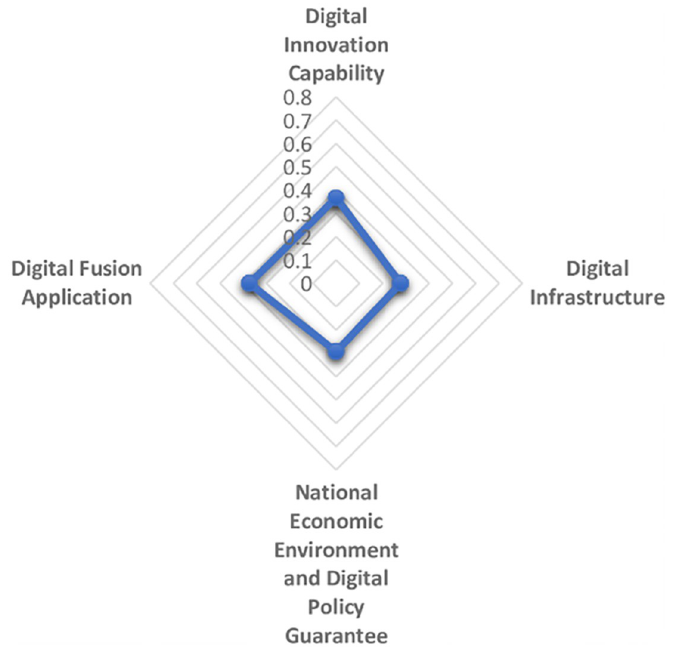
Fig 6. Radar map of eastern digital economy development.